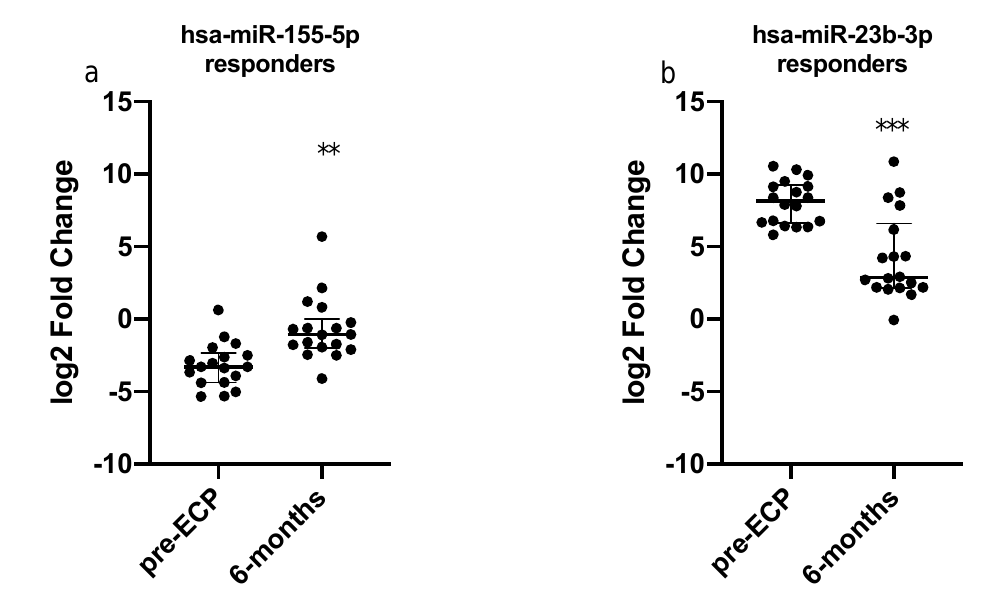
Figure 3. Quantitative expression of ( a ) miR-155 and ( b ) miR-23b assessed by qRT-PCR in responder patients. Relative expressions were expressed as log2 transformed values. *** p < 0.001; ** p <